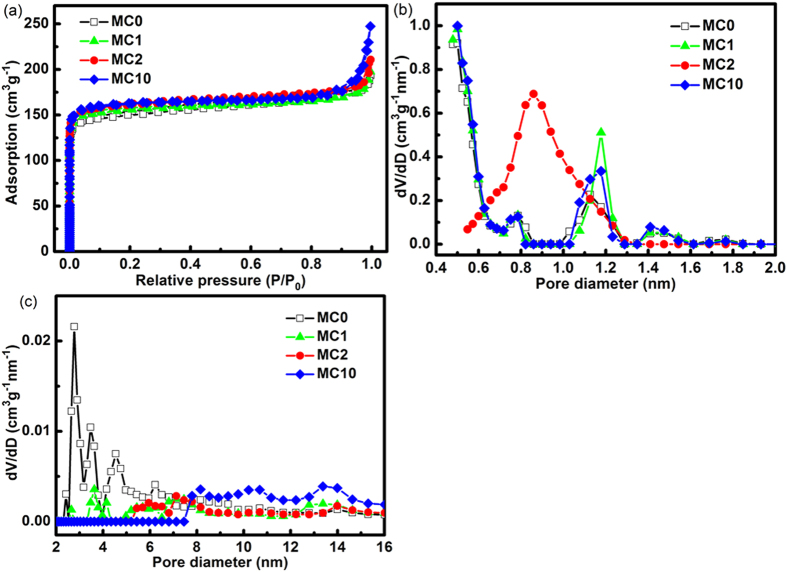
(a) N2 adsorption/desorption isotherms and (b,c) pore size distributions of MC samples.